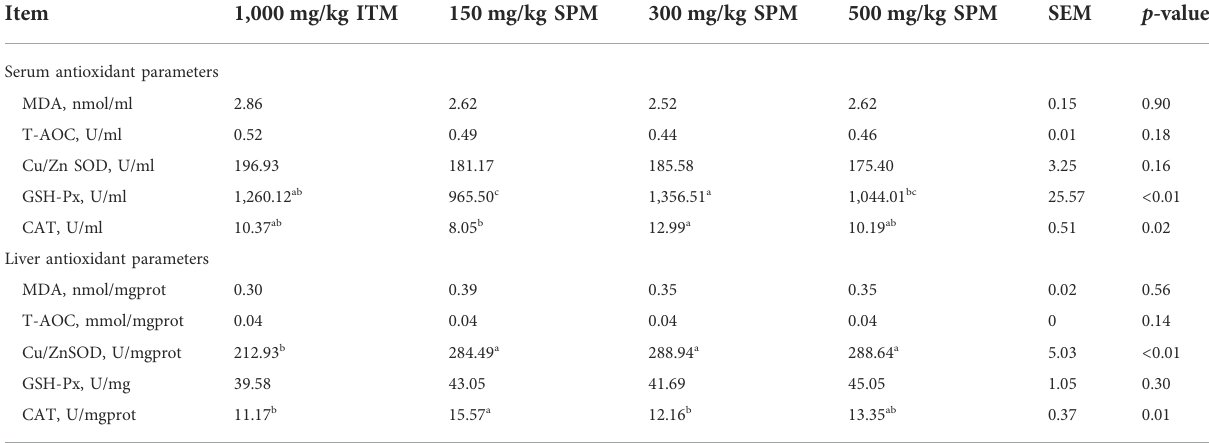
TABLE 6 Effect of supplementation of ITMs and SPMs in basal rations on serum and liver antioxidant parameters of chickens.